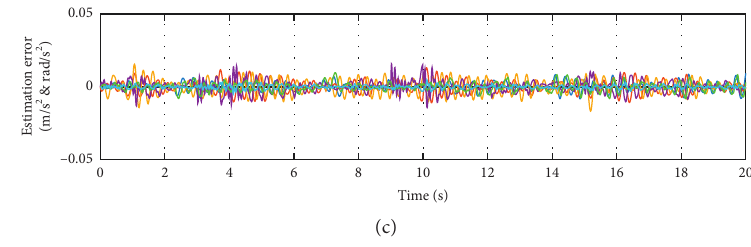
Figure 22: System responses in Scenario